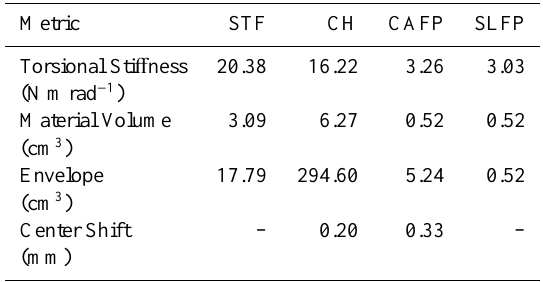
Table 2. Comparison of flexures for equal stress at 15 ◦ deflection.